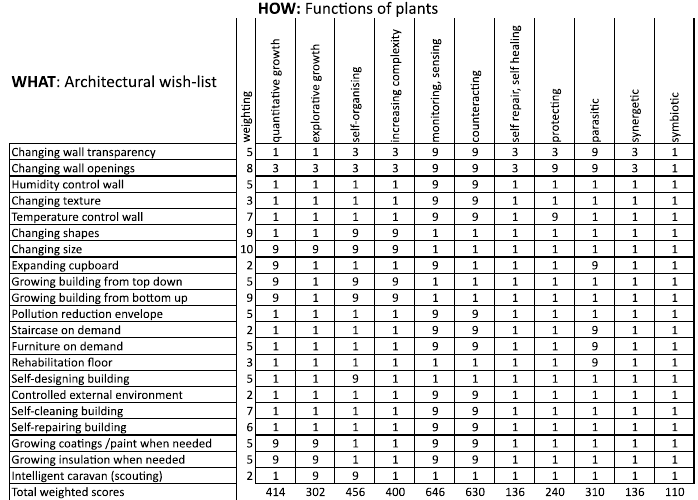
Figure 4. Quality Function Deployment QFD matrix with concepts, ranking, and data comparing architectural target concepts with botanical functions (numerical evaluation of strength of connection).